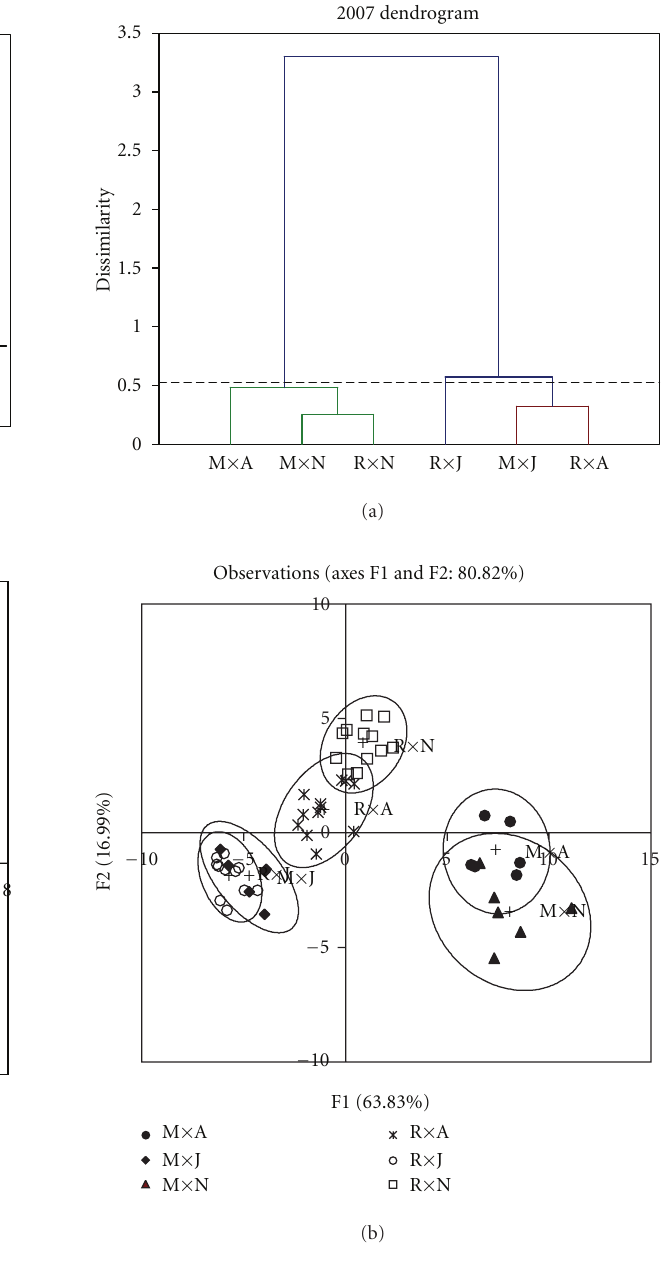
Figure 9: Results of cluster analyses conducted during 2006 on the community level physiological profiles of the soils, as measured using the Biolog EcoPlate method (a) dendrogram and (b) discriminant analysis (DA) (M = monoculture and R = rotation, J = June, A = August, and N = November).